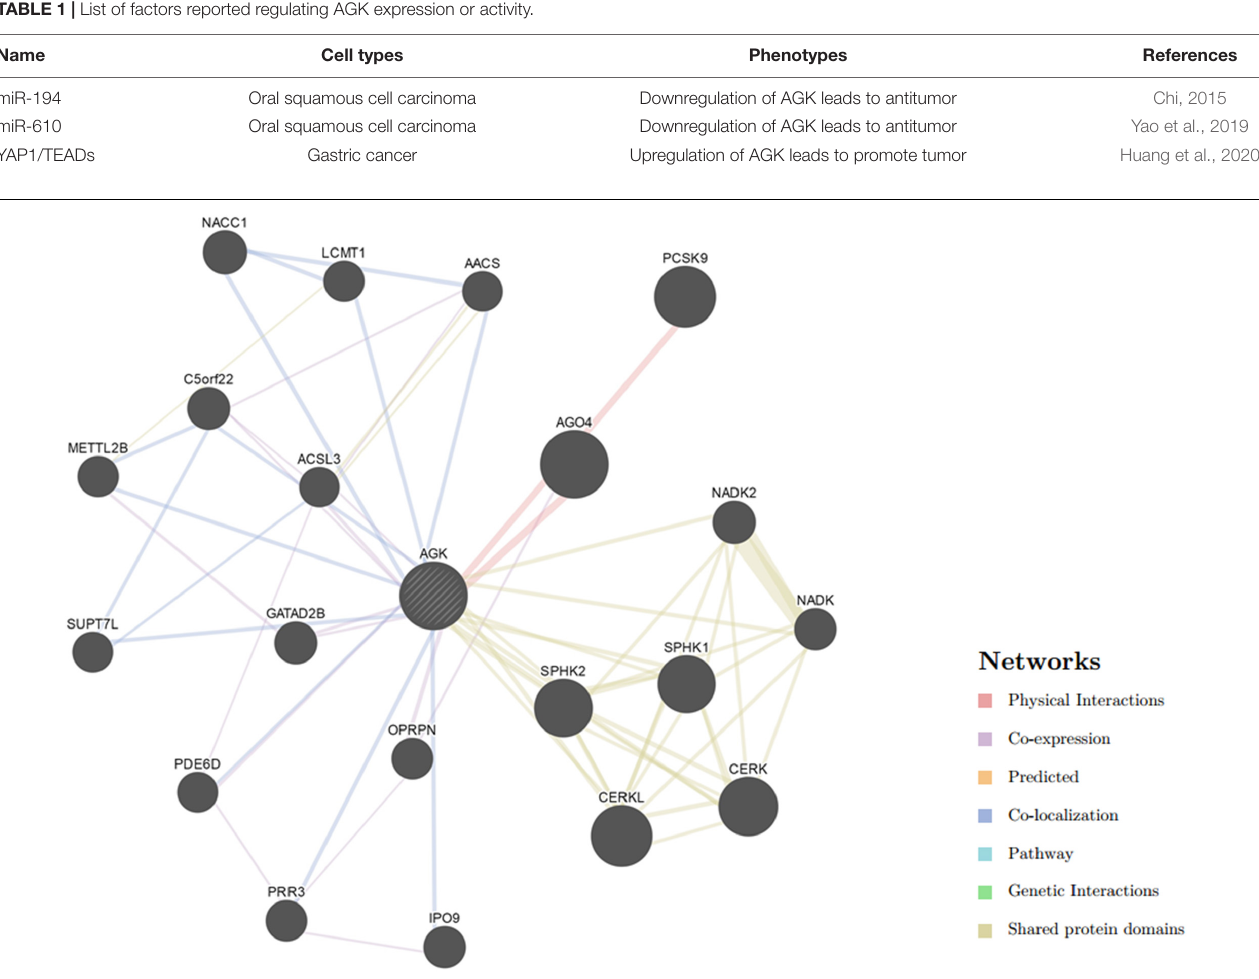
FIGURE 4 | Gene interaction network of AGK. The gene–gene interaction network was generated by GeneMANIA (Warde-Farley et al., 2010). AGO4, argonaute 4; RISC, catalytic component; CERKL, ceramide kinase like; PCSK9, proprotein convertase subtilisin/kexin type 9; CERK, ceramide kinase; SPHK1, sphingosine kinase 1; SPHK2, sphingosine kinase 2; NACC1, nucleus accumbens associated 1; NADK2, NAD kinase 2, mitochondrial; GATAD2B, GATA zinc finger domain containing 2B; C5orf22, chromosome 5 open reading frame 22; IPO9, importin 9; NADK, NAD kinase; OPRPN, opiorphin prepropeptide; PRR3, proline rich 3; METTL2B, methyltransferase like 2B; LCMT1, leucine carboxyl methyltransferase 1; PDE6D, phosphodiesterase 6D; SUPT7L, SPT7-like STAGA complex gamma subunit; AACS, acetoacetyl-CoA synthetase; ACSL3, acyl-CoA synthetase long-chain family member